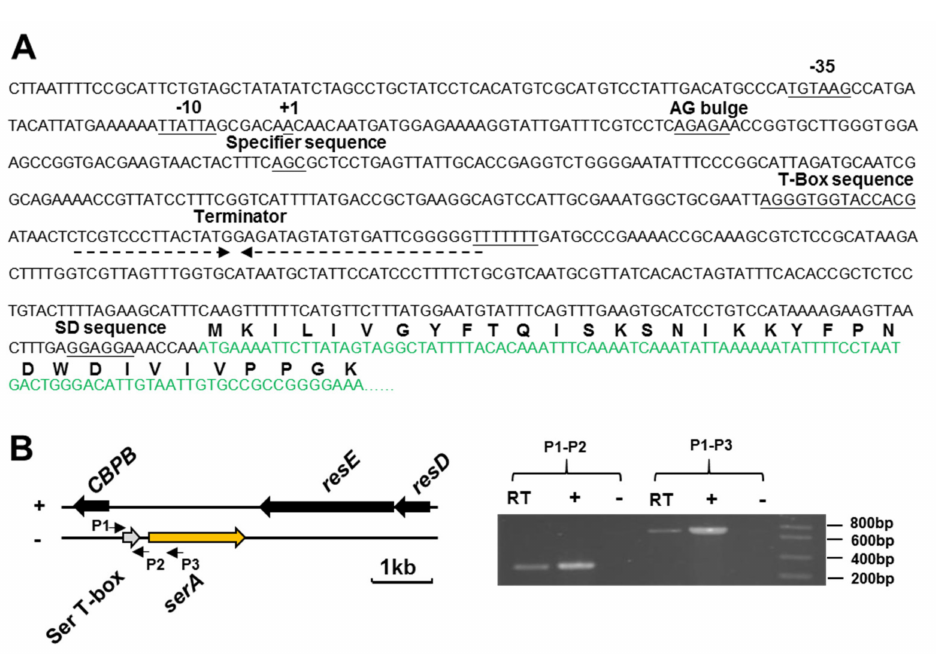
Figure 4. Characterization of the T-box region of the serA gene of P. polymyxa WLY78. ( A ) The leader sequence and some conserved features of the Ser T-box region. TSS site (+1), − 35/ − 10 region, AG bulge, T-box sequence, and terminator region are shown. ( B ) Identification of Ser T-box RNA by RT-PCR. The Ser T-box region is indicated by an arrow in grey color and serA gene in orange color. P1, P2, and P3 that represented by little arrows are primers for RT-PCR. A 252 bp fragment obtained by using P1 and P2 primers and a 686 bp fragment obtained by using P1 and P3 primers are shown on the agarose gel. RT, standard RT-PCR reaction; (–), negative control in which no reverse transcriptase was added to the RT reaction; (+), positive control in which genomic DNA was used as a template in the